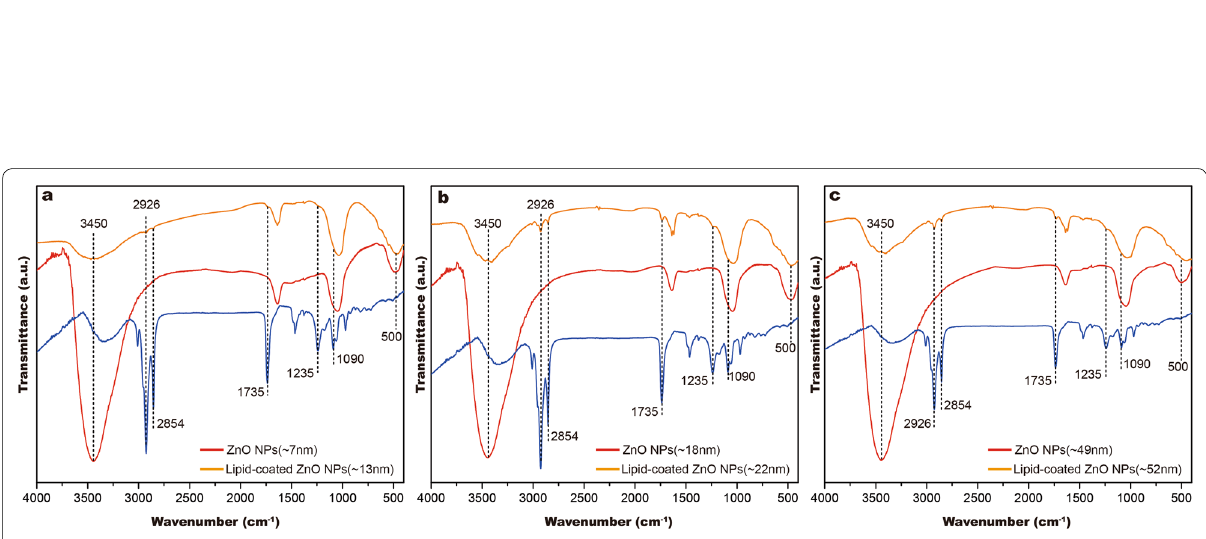
Fig. 4 The structural properties of ZnO and lipid-coated ZnO NPs. The FT-IR spectra of a ZnO NPs(~ 7 nm) and lipid-coated ZnO NPs(~ 13 nm); b